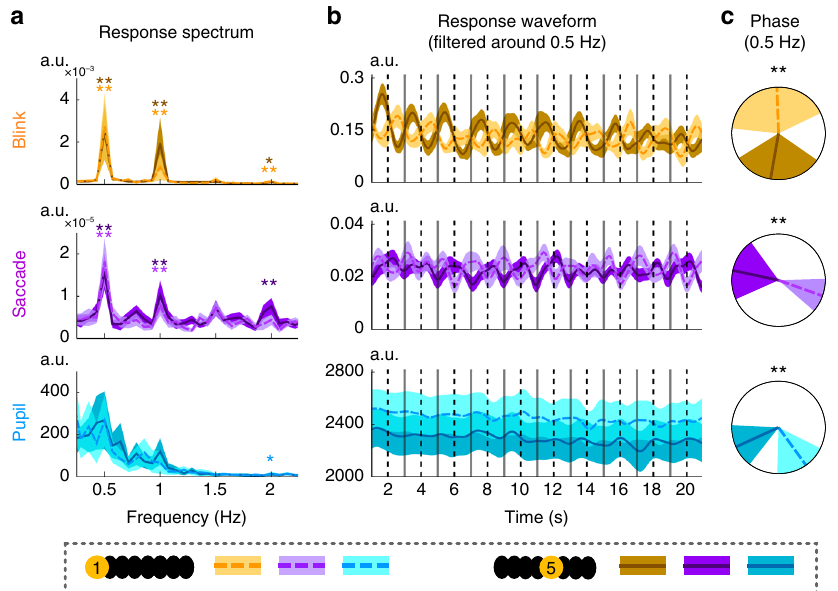
Fig. 5 Ocular tracking of eight-tone perceptual groups in a tone sequence. a Response spectrum. A response peak at 0.5 Hz is observed for the blink/ saccade rate (see Supplementary Table 5 for the P -value, mean, and SEM, N = 16), corresponding to the 2-s period of the eight-tone perceptual group. The fi gure setup is the same as Fig. 4. b Response waveform fi ltered around 0.5 Hz, which is strongly modulated by attention. c The response phase extracted by the Fourier analysis. The shaded area covers the 95% con fi dence interval of the mean phase. * P < 0.05; ** P <